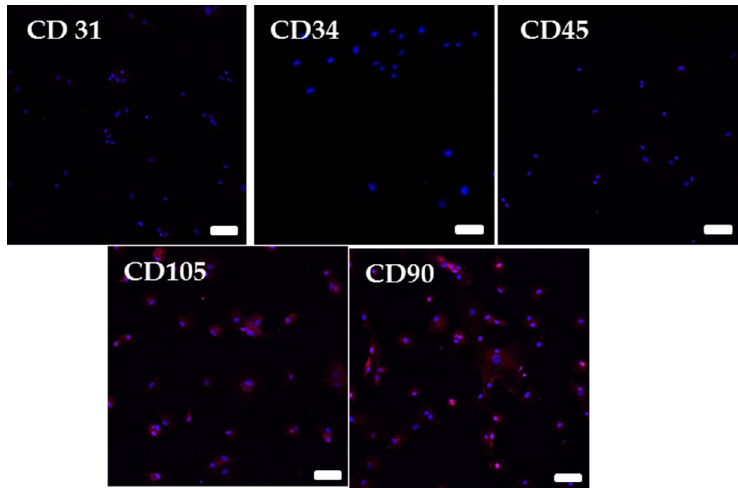
Figure 2. Immunofluorescent staining of the mesenchymal stem cells (MSCs) for the markers CD31, CD34, CD45, CD90 and CD105 with DAPI-stained nuclei; (calibration = 50 µm).